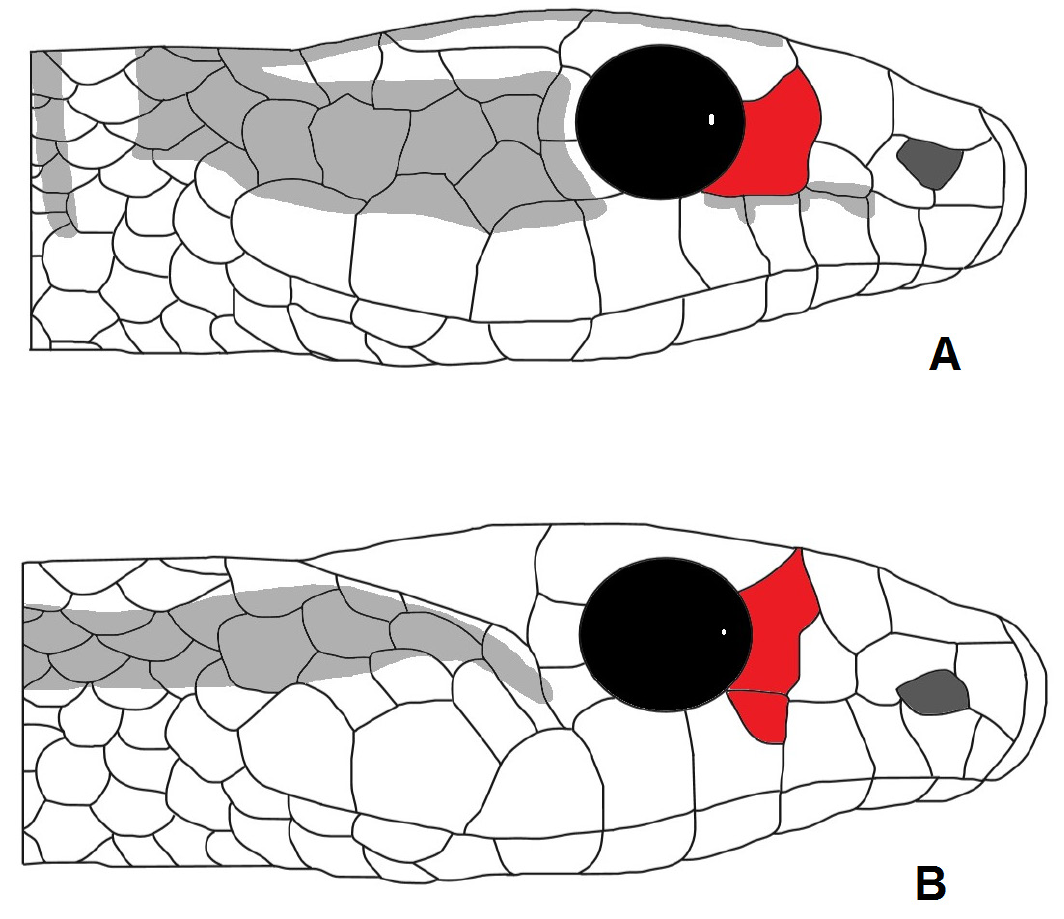
Fig. 12. A . Single preocular. B . Preocular generally